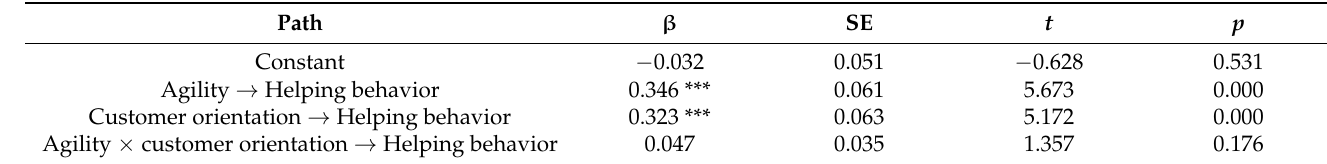
Table 9. Moderating effect for ICT companies.